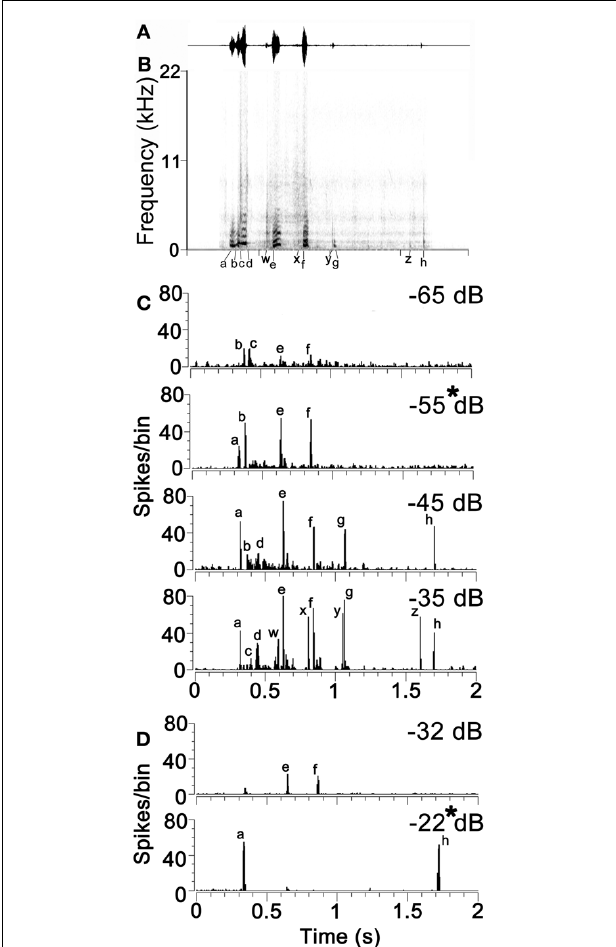
FIGURE 2 | (A) The waveform and (B) the spectrogram of the example of chutter used in this study. The eight temporal elements of the call that are capable of producing a neuronal response at low sound levels are indicated by the letters (a) to (h) below the time axis. Quieter elements of the call that only produce a neuronal response at relatively high sound levels are indicated by the letters (w) to (z). (C) Responses of a unit in AI(LF) to the chutter call presented at four different attenuation levels from − 65dB (quietest) to − 35dB (loudest). Individual peaks in the response corresponding to the different temporal elements of the spectrogram are indicated by the same letters as in panel (B) . This unit had a CF of 1kHz and a pure tone threshold of 25dB SPL. (D) Separate unit in AI(LF) which showed different responses to chutter at two different levels of attenuation. This unit had a CF of 0.4kHz and a pure tone threshold of 58dB